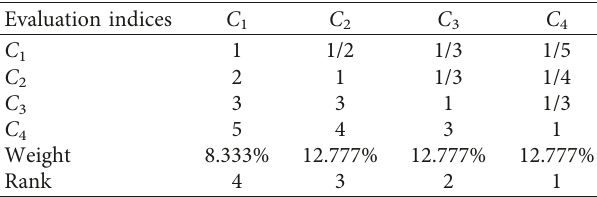
Table 4: Weights and rank of the adaptability evaluation